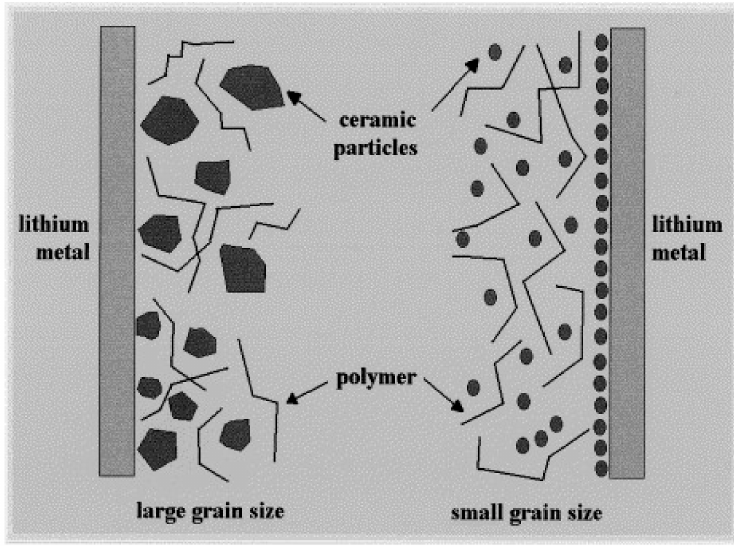
Figure 4. Schematic illustration of Metal lithium electrode/composite electrolyte interface